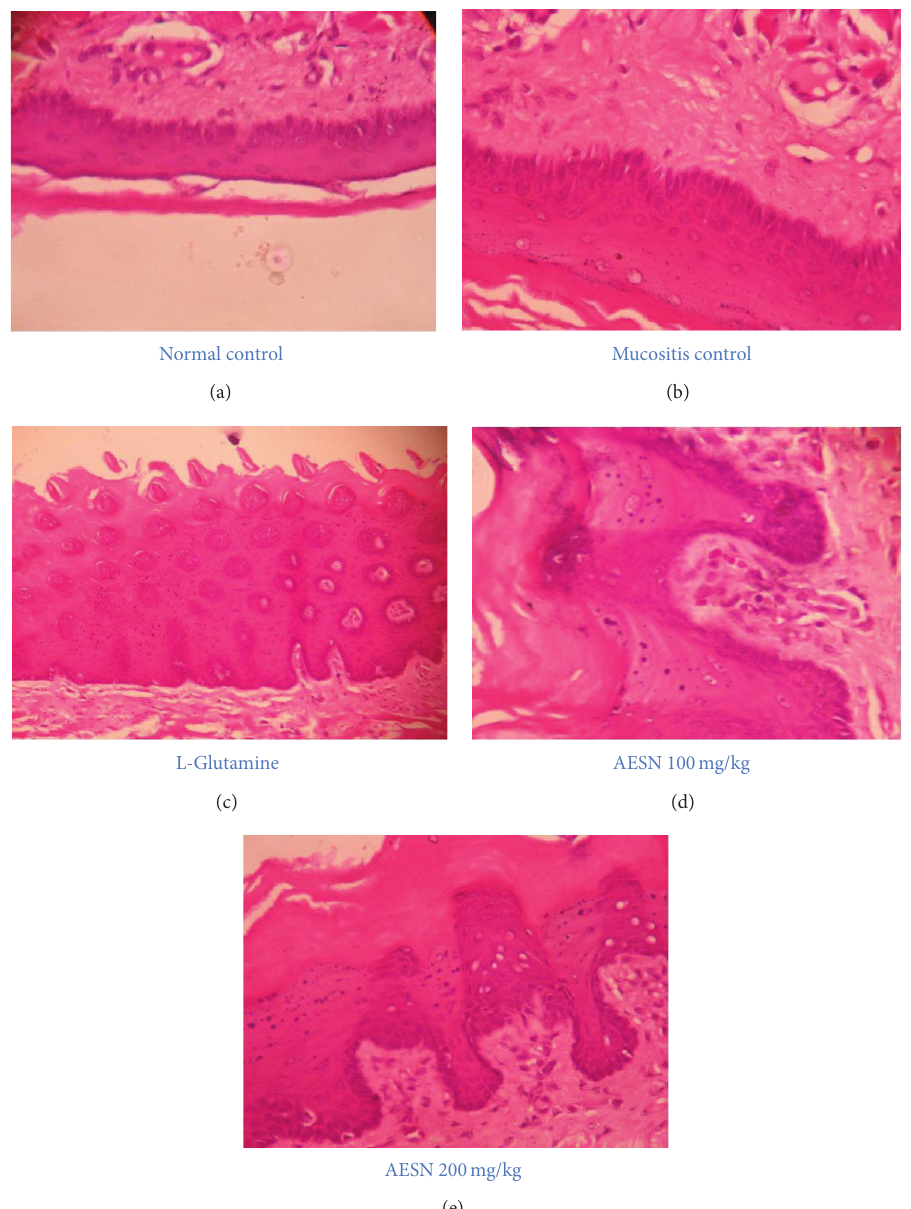
Figure 6: Histology of tongue section of different groups after busulfan/infrared irradiation. (a) Normal control, (b) mucositis control, (c) L-glutamine, (d) AESN 100mg/kg, and (e) AESN 200 mg/kg. Magnification 40x.